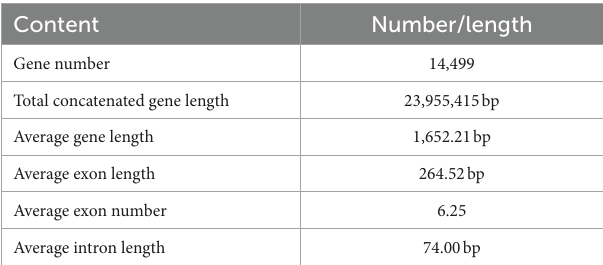
TABLE 2 Characteristics of the gene prediction of Lyophyllum decastes (LRG-d1-1).